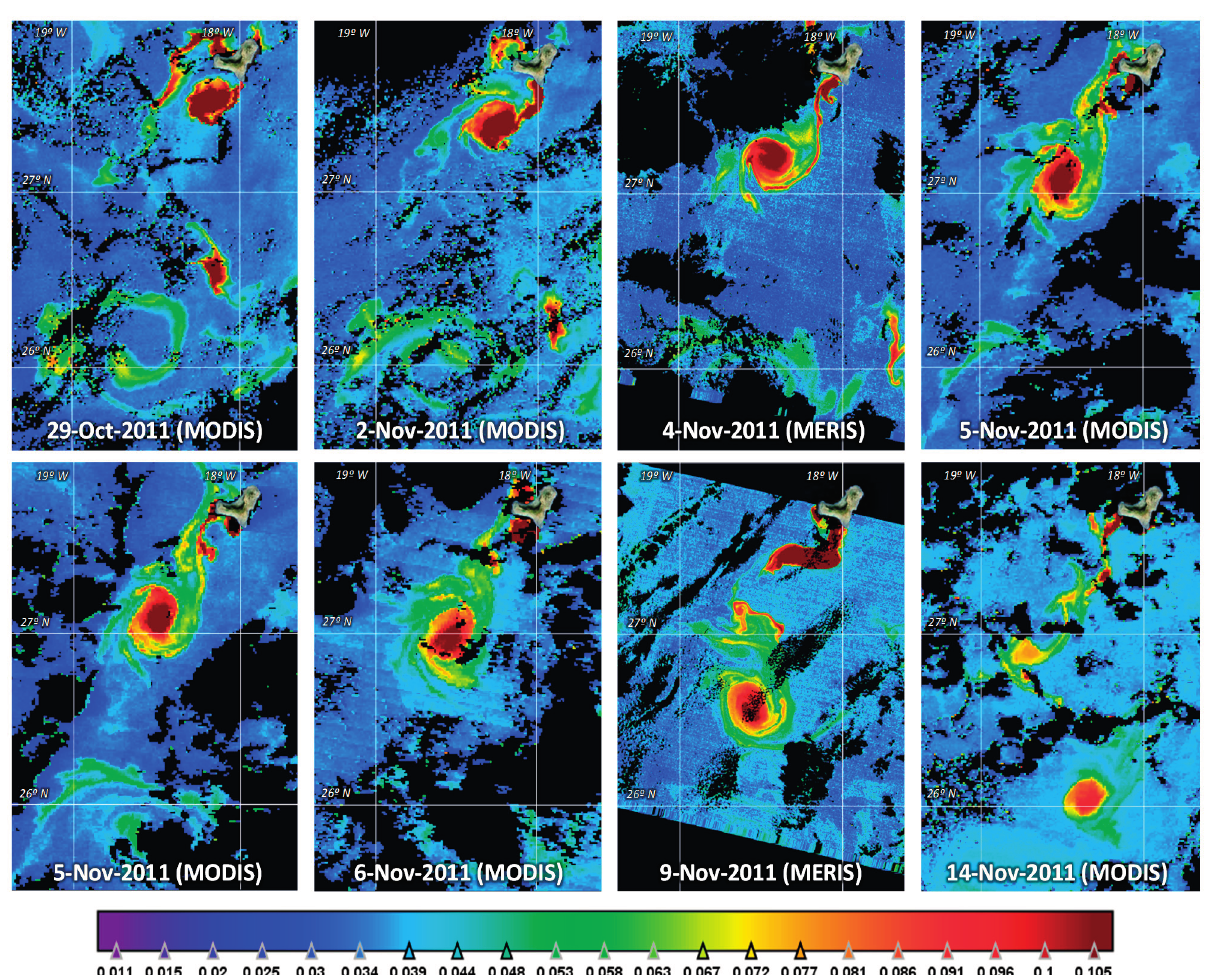
Figure 2. Multitemporal K d product generated from MODIS (Terra and Aqua) and MERIS (ENVISAT) data during October and November